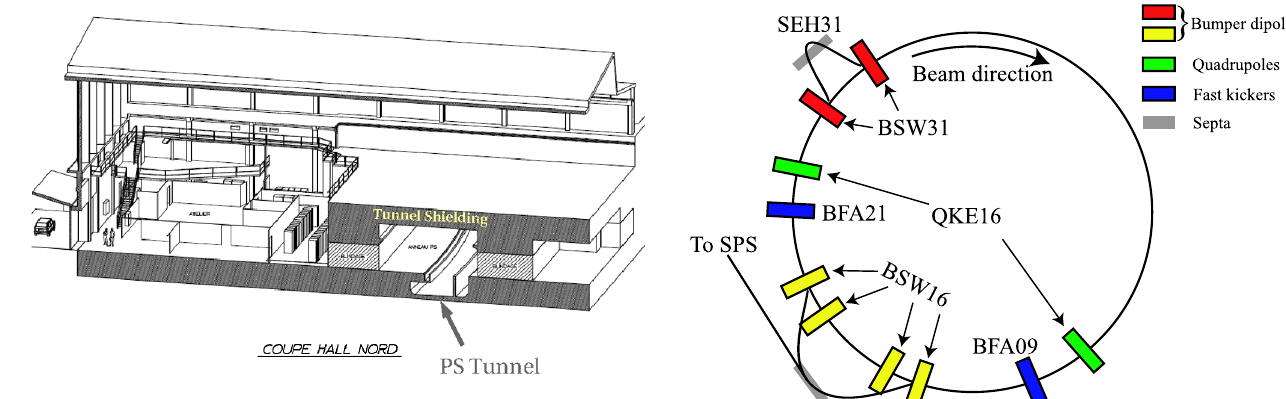
extraction.FIG. FIG. 4. Layout of all elements used during the CT